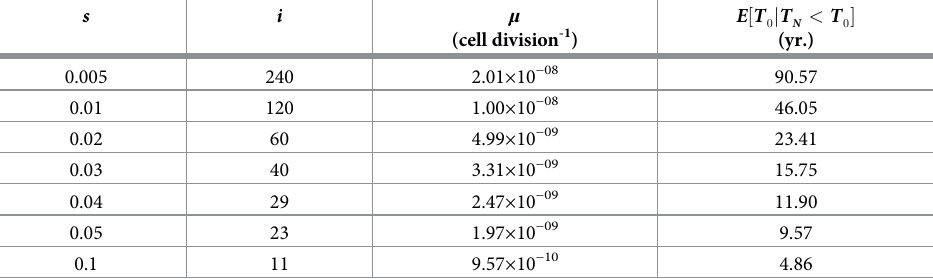
Table 1. Results of the computations of the expected time to